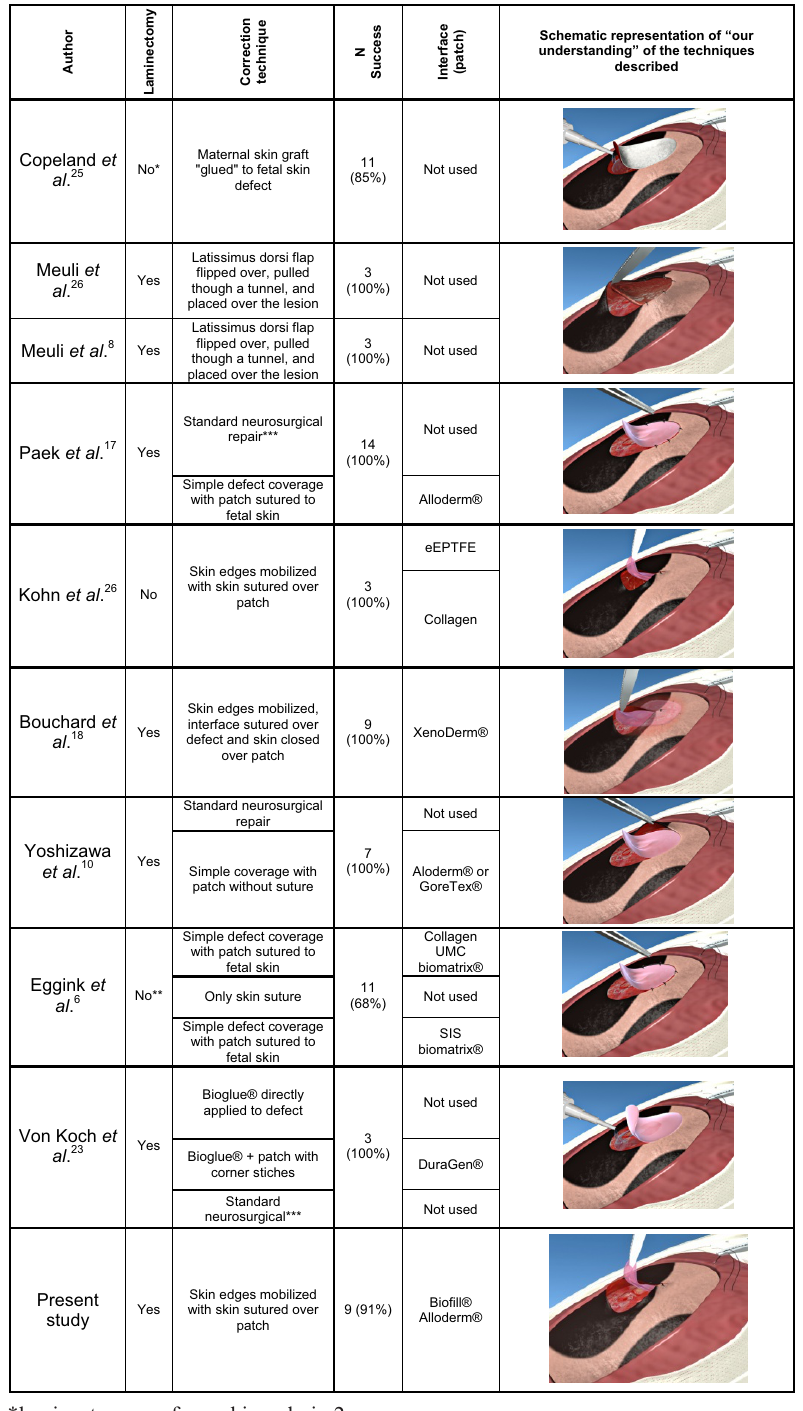
CHART 1 - Summary and schematic representation of published prenatal techniques for correction of MMC-like defects in fetal sheep